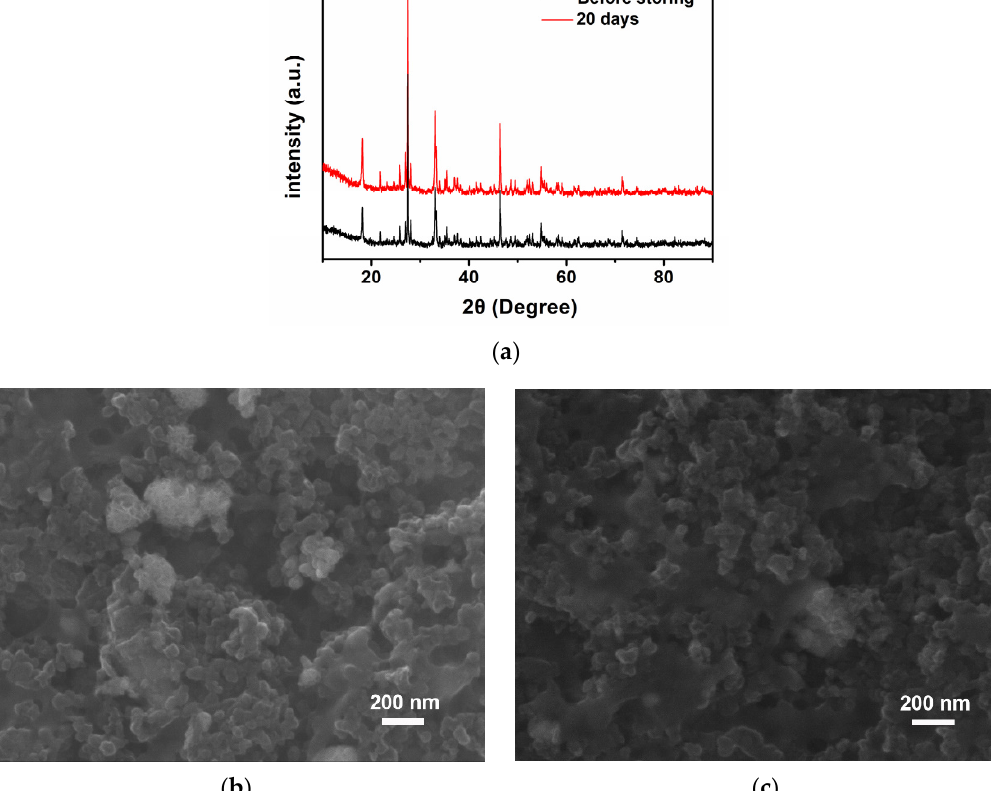
Figure 7. ( a ) XRD patterns of the fresh air cathode and air cathode stored for 20 days. ( b ) SEM images of the fresh air cathode and ( c ) air cathode stored for 20 days.